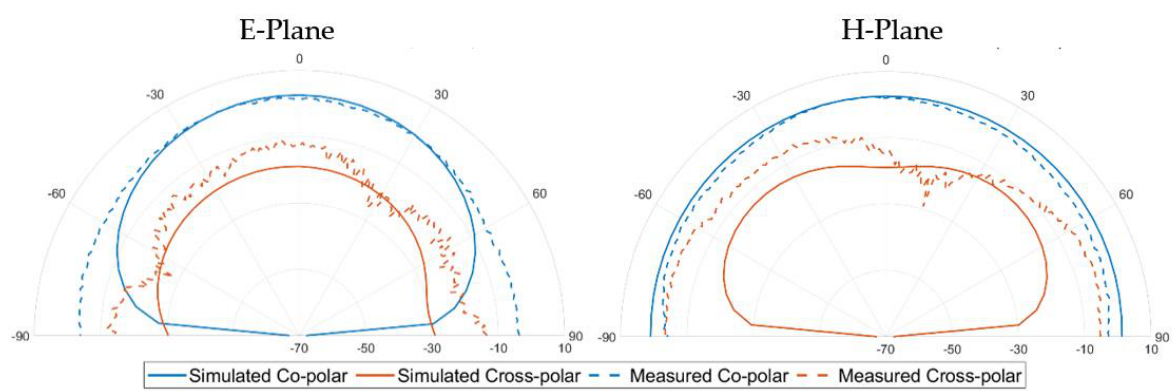
Figure 14. Comparison of measured and simulated radiation patterns for the Minkowski pre-fractal-based PIFA design in the E and H planes at 2.34 GHz.